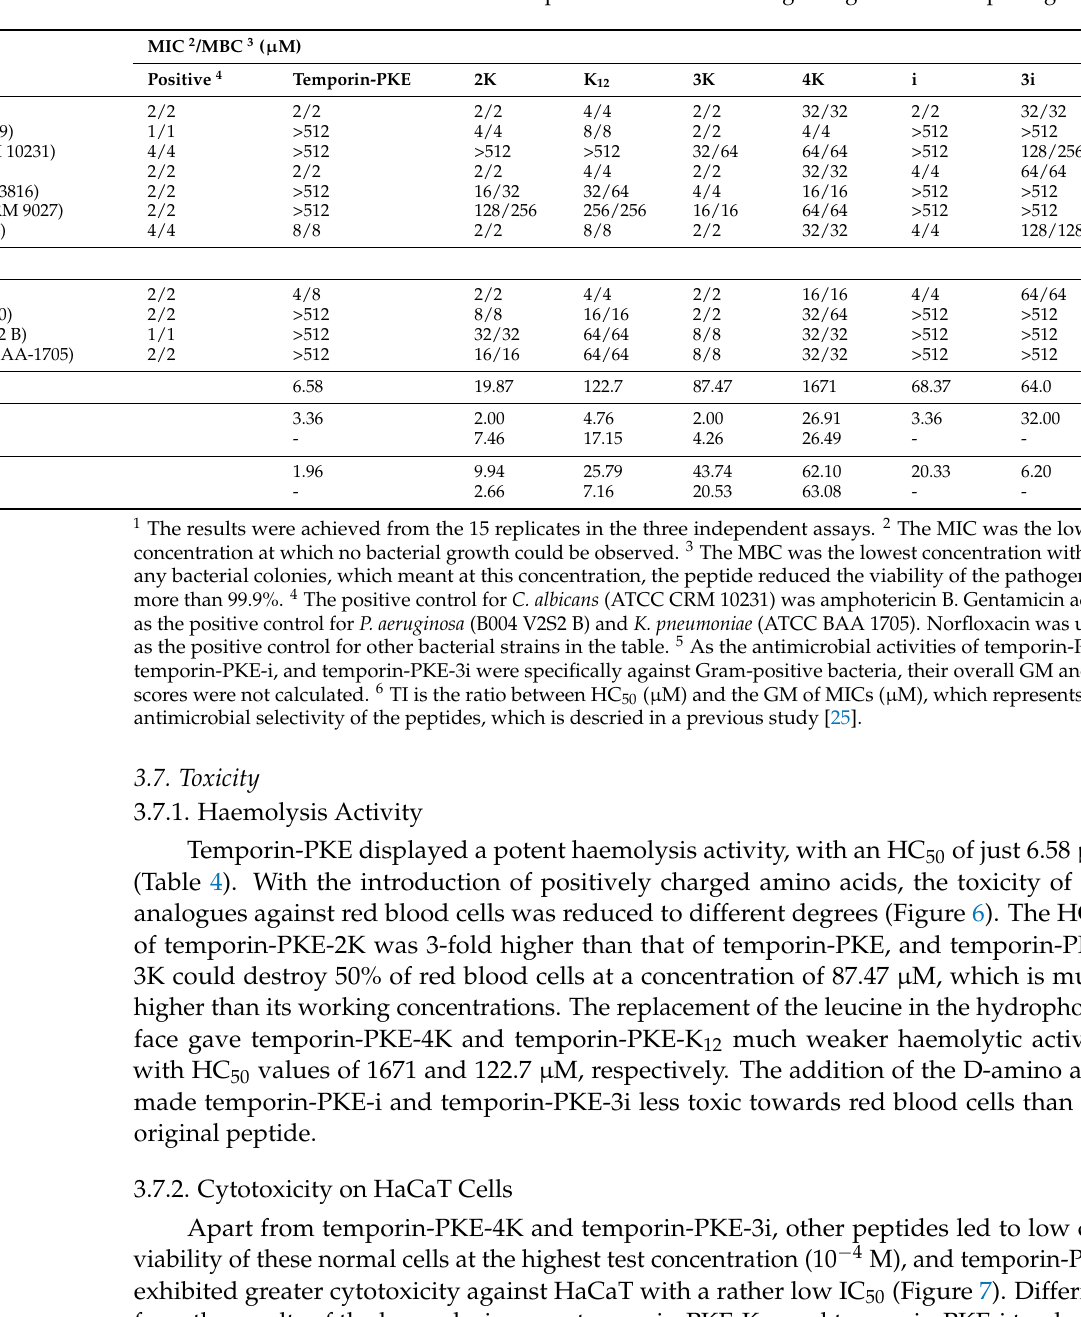
Table 4. The MIC and MBC values of temporin-PKE and its analogues against several pathogens 1